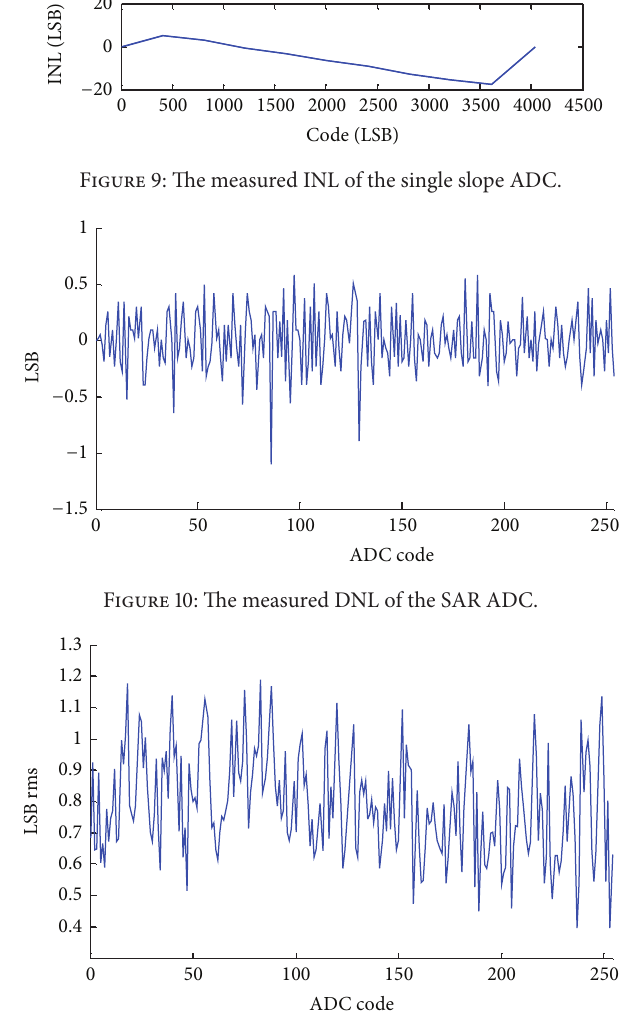
Figure 11: The measured SAR ADC output